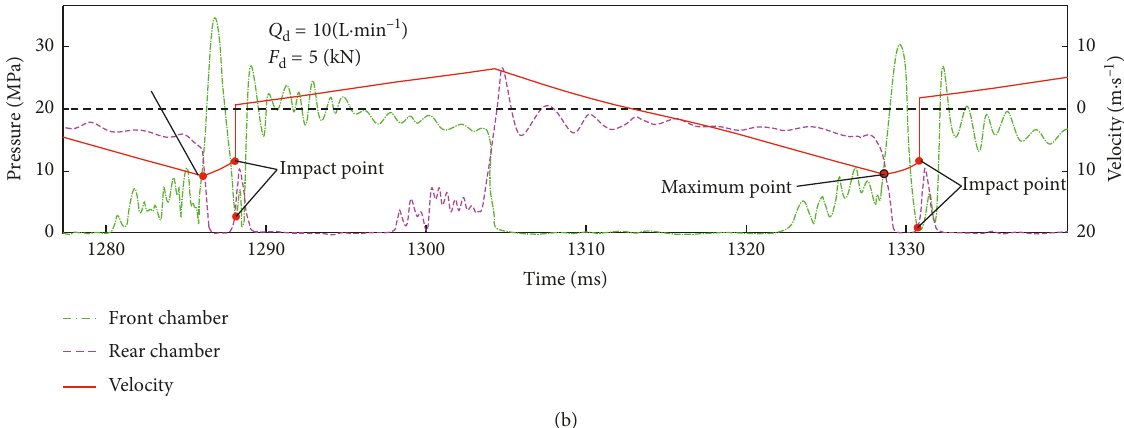
Figure 12: The comparisons of motion laws of the impact piston under different combinations ( Q